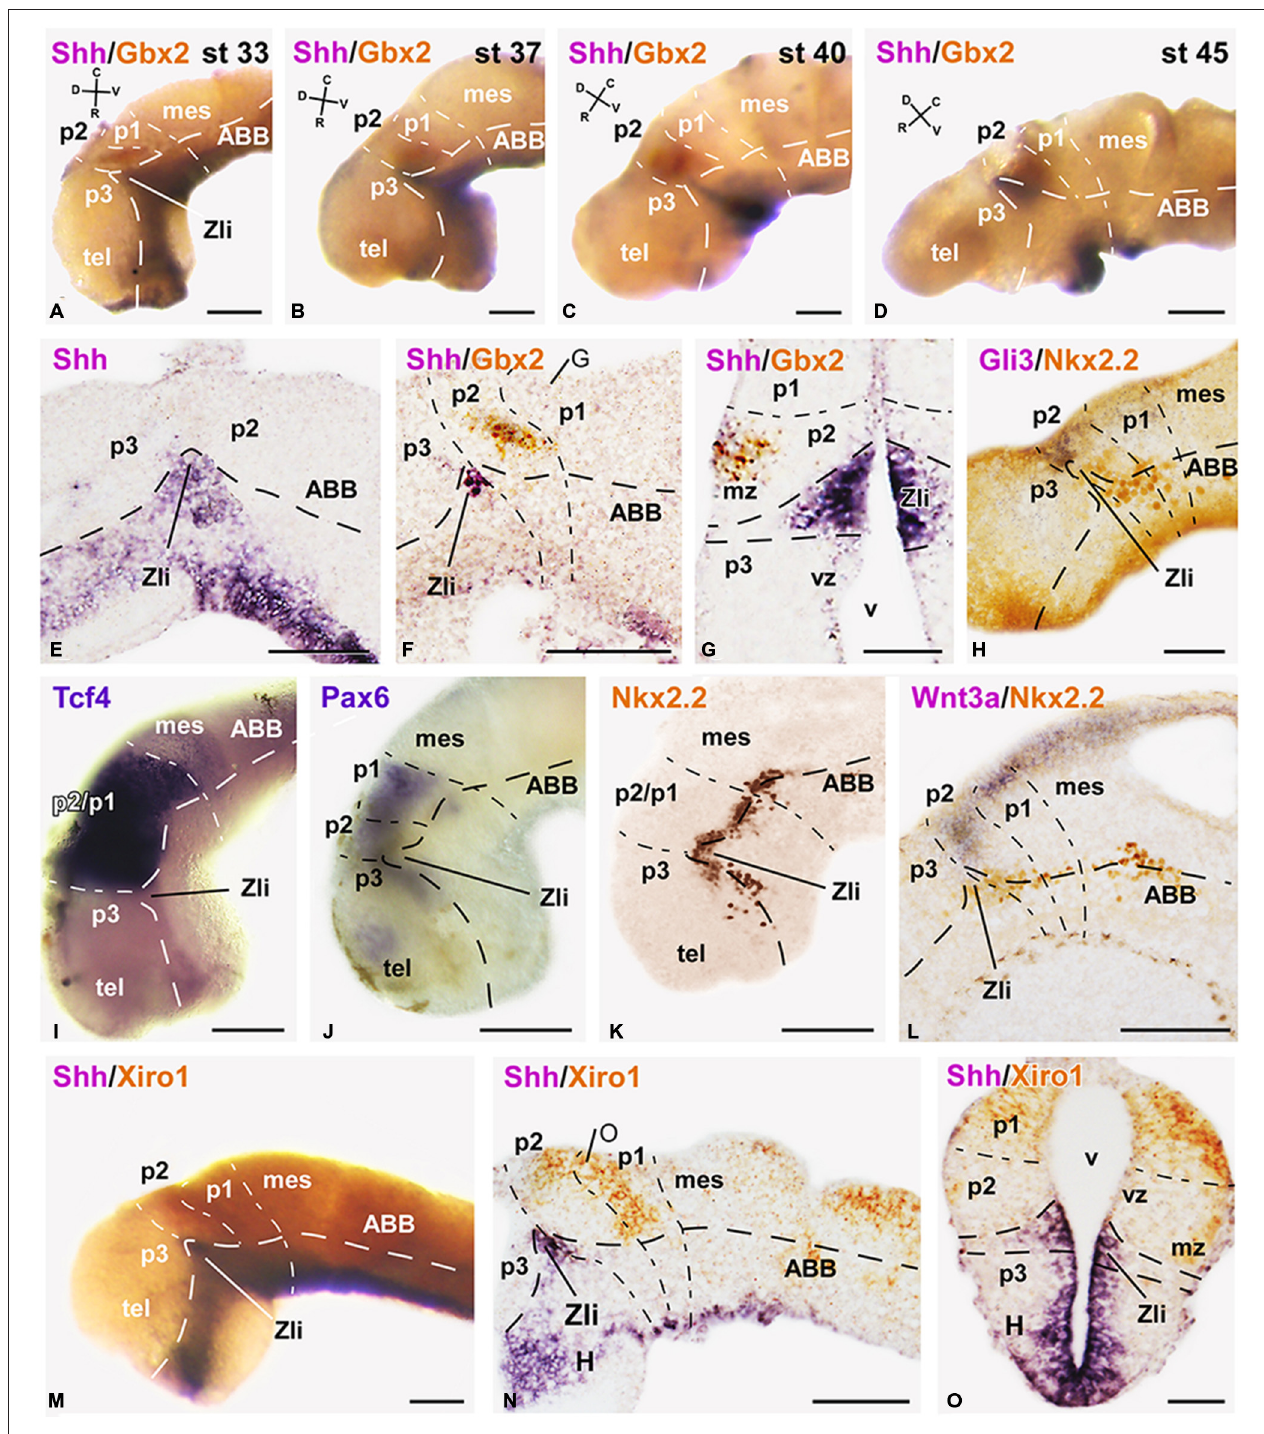
mounts (I,J,M) and sagittal (E,F,H,K,L,N) or transverse (G,O) sections of embryos at stages 33/34. The photographs correspond to single ISH (E,I,J) , single immunohistochemistry (IHC; K ), and combinations of double ISH (F,G,M–O) or combined ISH and IHC (H,L) . The markers labeled are indicated in the upper left of each photograph. All images are oriented following the same standard: dorsal is upwards in ( Continued